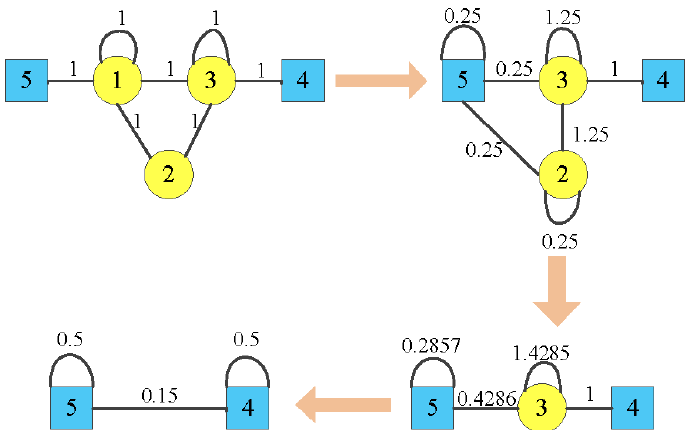
Figure 8. IEEE 5-bus system reduction process without proposed node ordering